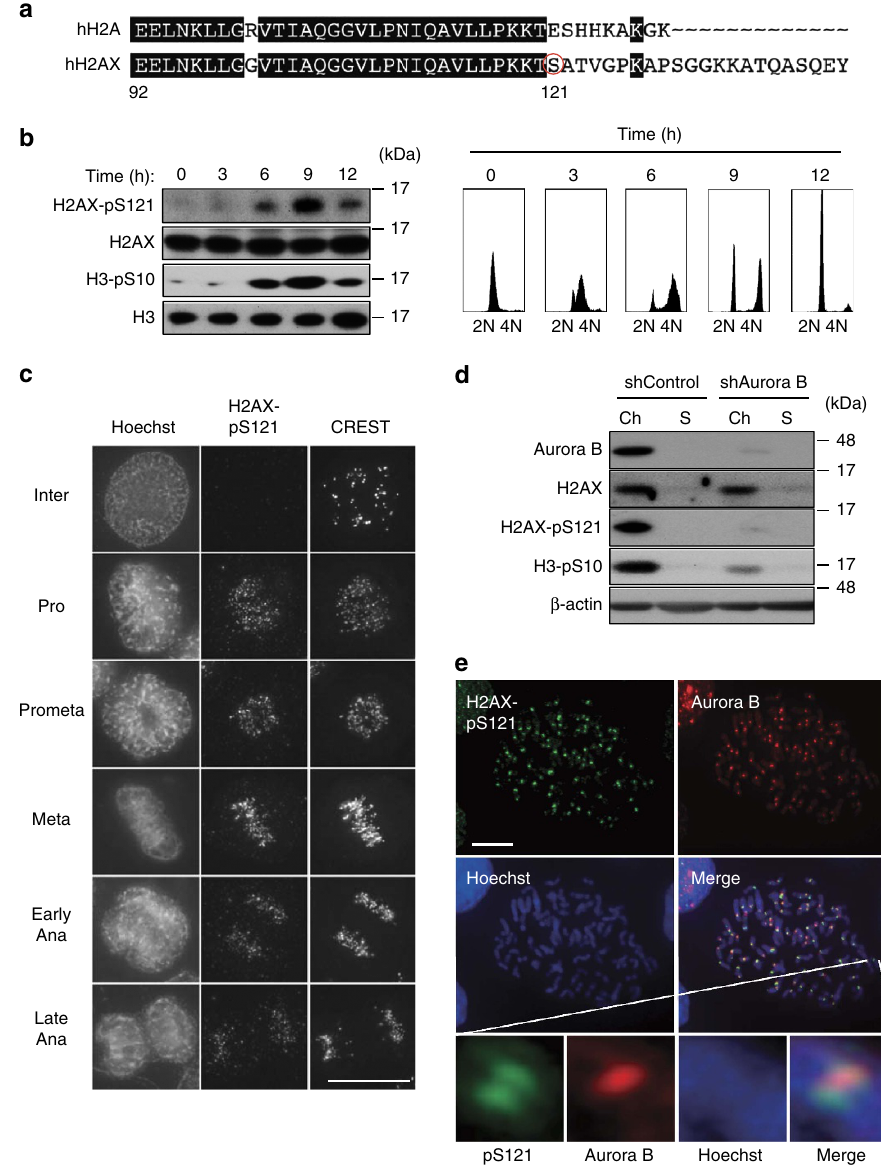
Figure 2 | Mitotic phosphorylation of H2AX at S121 predominantly localizes at centromeres and is mediated by Aurora B. ( a ) Sequence alignment of C-terminal regions of Homo sapiens H2A and H2AX. Amino acids conserved in both histones are highlighted in black. S121 of H2AX is circled in red. ( b ) HeLa cells were synchronized by a double thymidine block and released into S phase. Cells were harvested at the indicated times and the lysates were subjected to immunoblotting with the indicated antibodies (left). Cell cycle profiles at the indicated times were monitored by FACS analysis (right). ( c ) Asynchronously growing HeLa cells were fixed and stained with anti-H2AX-pS121 and CREST antibodies. DNA was counterstained with Hoechst. Representative images captured during the cell cycle are shown. Scale bar, 10 m m. ( d ) HeLa cells expressing the Dox-inducible shControl or shAurora B were cultured in the presence of doxycycline (1 m gml (cid:2) 1 ) for 3 days and treated with nocodazole (0.1 m gml (cid:2) 1 ) for 12h. After mitotic shake-off, chromatin (Ch) and soluble (S) fractions from mitotic cells were subjected to immunoblotting using the indicated antibodies. ( e ) Chromosome spreads were prepared from HeLa cells and stained with antibodies against H2AX-pS121 (green) and Aurora B (red). DNA was counterstained with Hoechst (blue). Prometaphase chromosomes and magnified images of paired sister chromatids are shown. Scale bar, 10 m